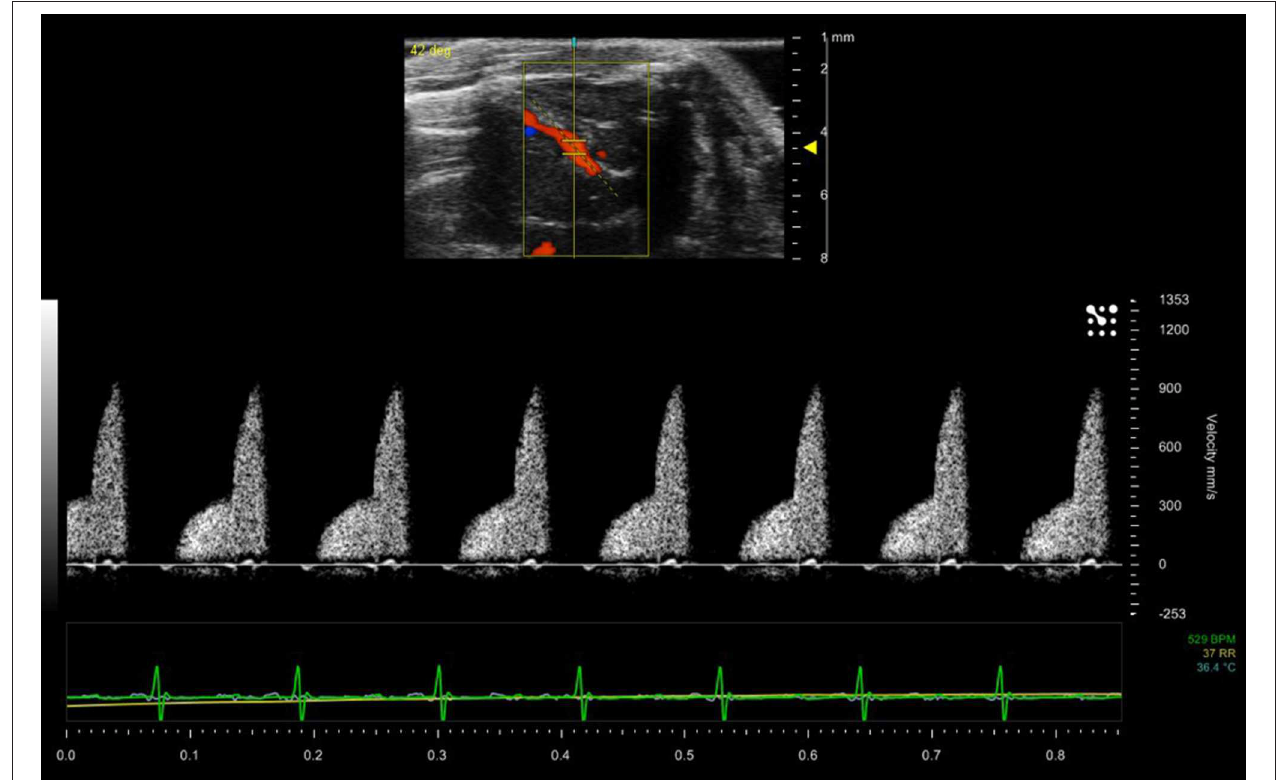
FIGURE 11 | Blood flow within the left anterior descending coronary artery of a mouse model. Maximum velocity within the artery is 900